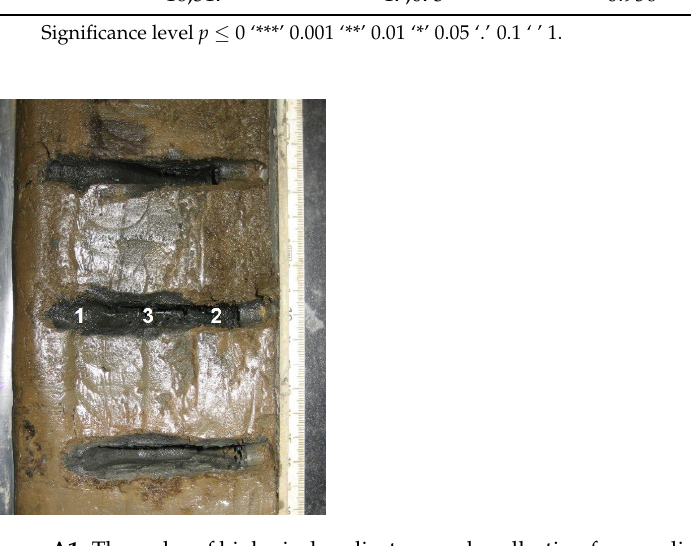
Figure A1. The order of biological replicate sample collection from sediment layers.